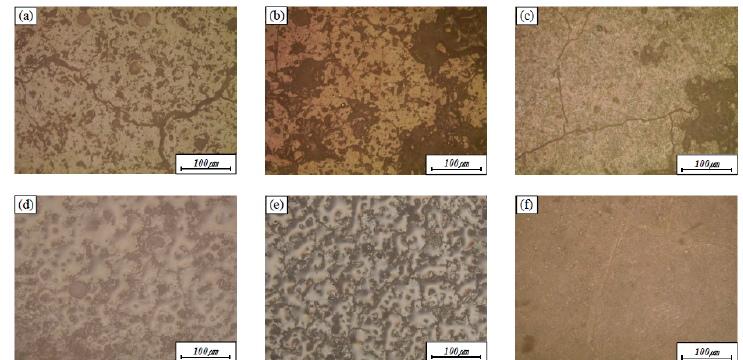
Figure 5. Optical micrographs of the surface of the EBCs after the thermal shock test at 1350 °C: ( a ) mullite, 2000 cycles; ( b ) mullite + Yb 2 SiO 5 , 2000 cycles; ( c ) Y 2 SiO 5 , 2000 cycles; ( d ) mullite, 4000 cycles; ( e ) mullite + Yb 2 SiO 5 , 4000 cycles; and ( f ) Y 2 SiO 5 , 4000 cycles.